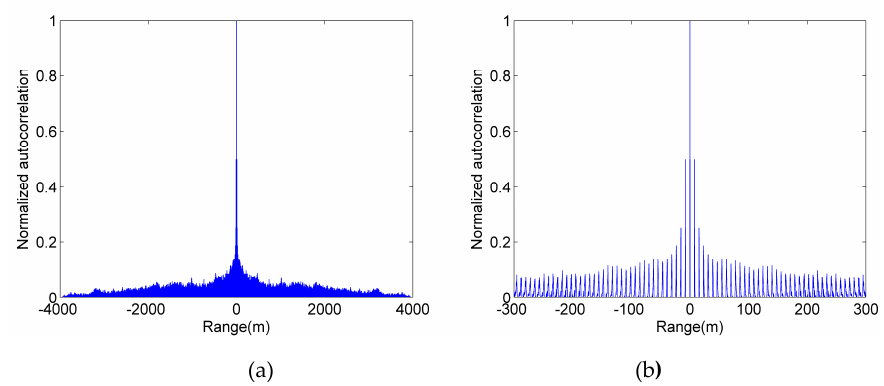
Figure 1. Autocorrelation function of the first modulated pseudo-random sequence. ( a ) global ( b ) local enlarged.